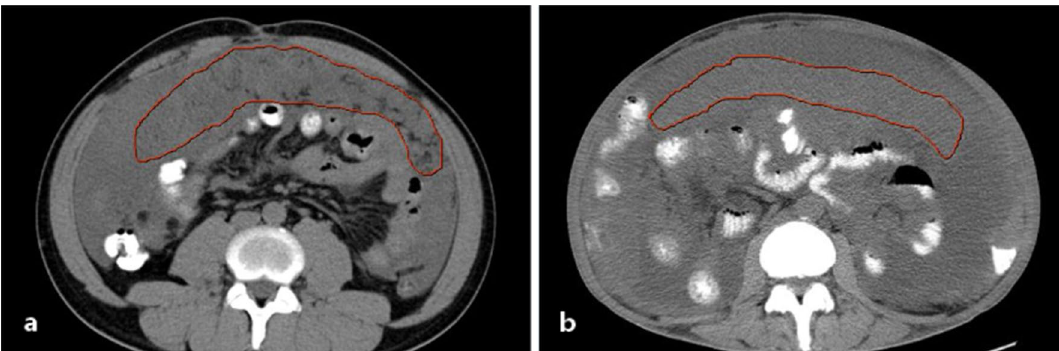
Figure 2. The CT ROI area of the greater-omental caking. ( a ) A 37-year-old man with low-grade PMP; the red curve shows greater omental caking. ( b ) A 62-year-old woman with high-grade PMP; the red curve shows greater omental